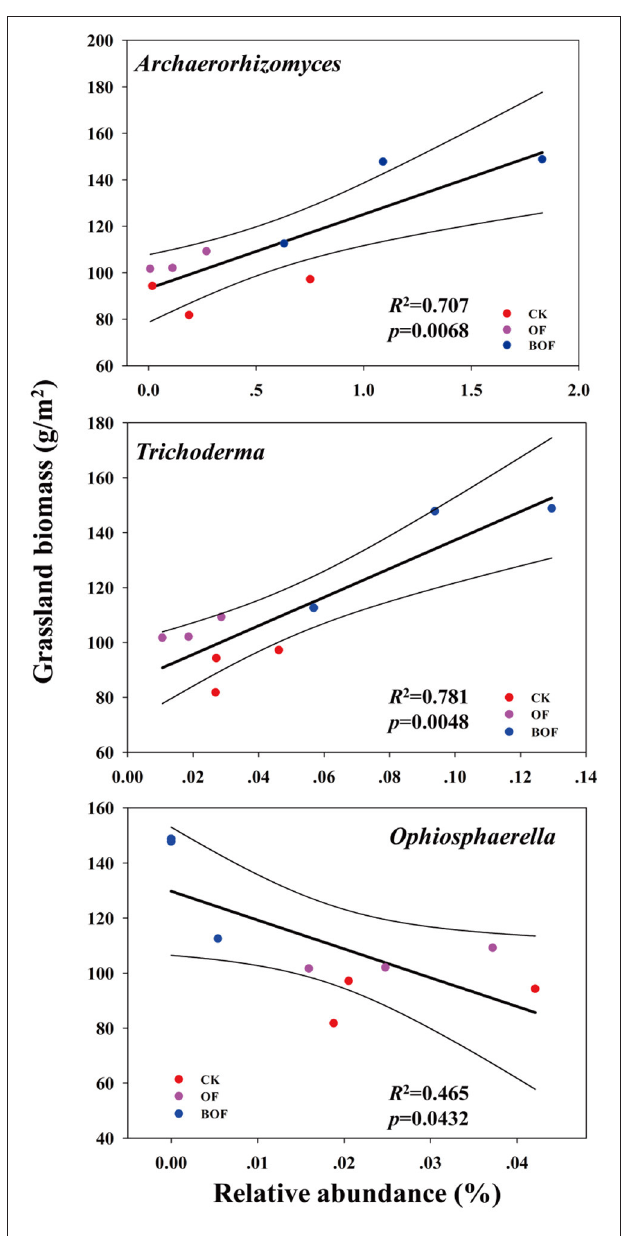
FIGURE 4 | Correlations ( p < 0.05) between key fungal genera (from Figure 3 ) and aboveground grassland